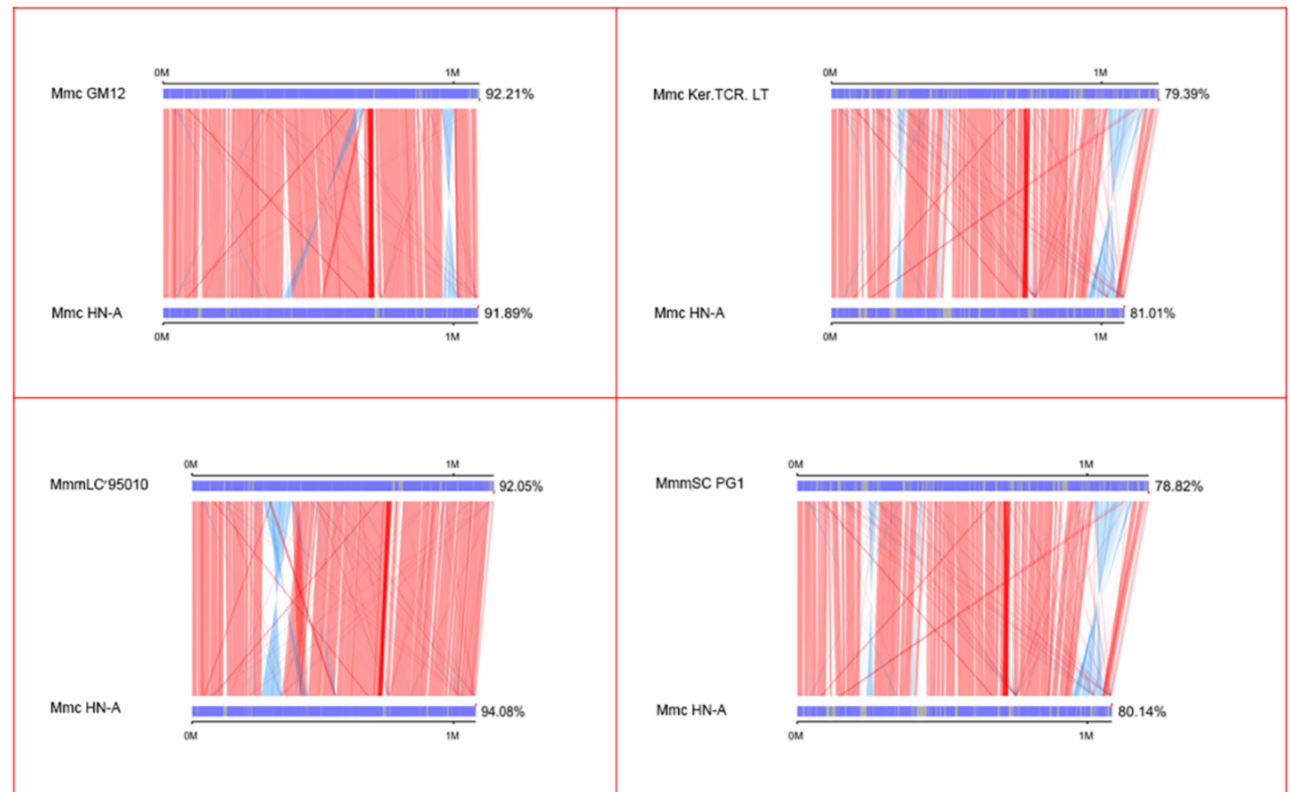
Figure 5. Parallel collinearity result plot. The upper axis is the target species genome; the lower axis is the reference genome; the red line represents the forward matching of the corresponding region; the blue line represents the reverse matching of the corresponding region.